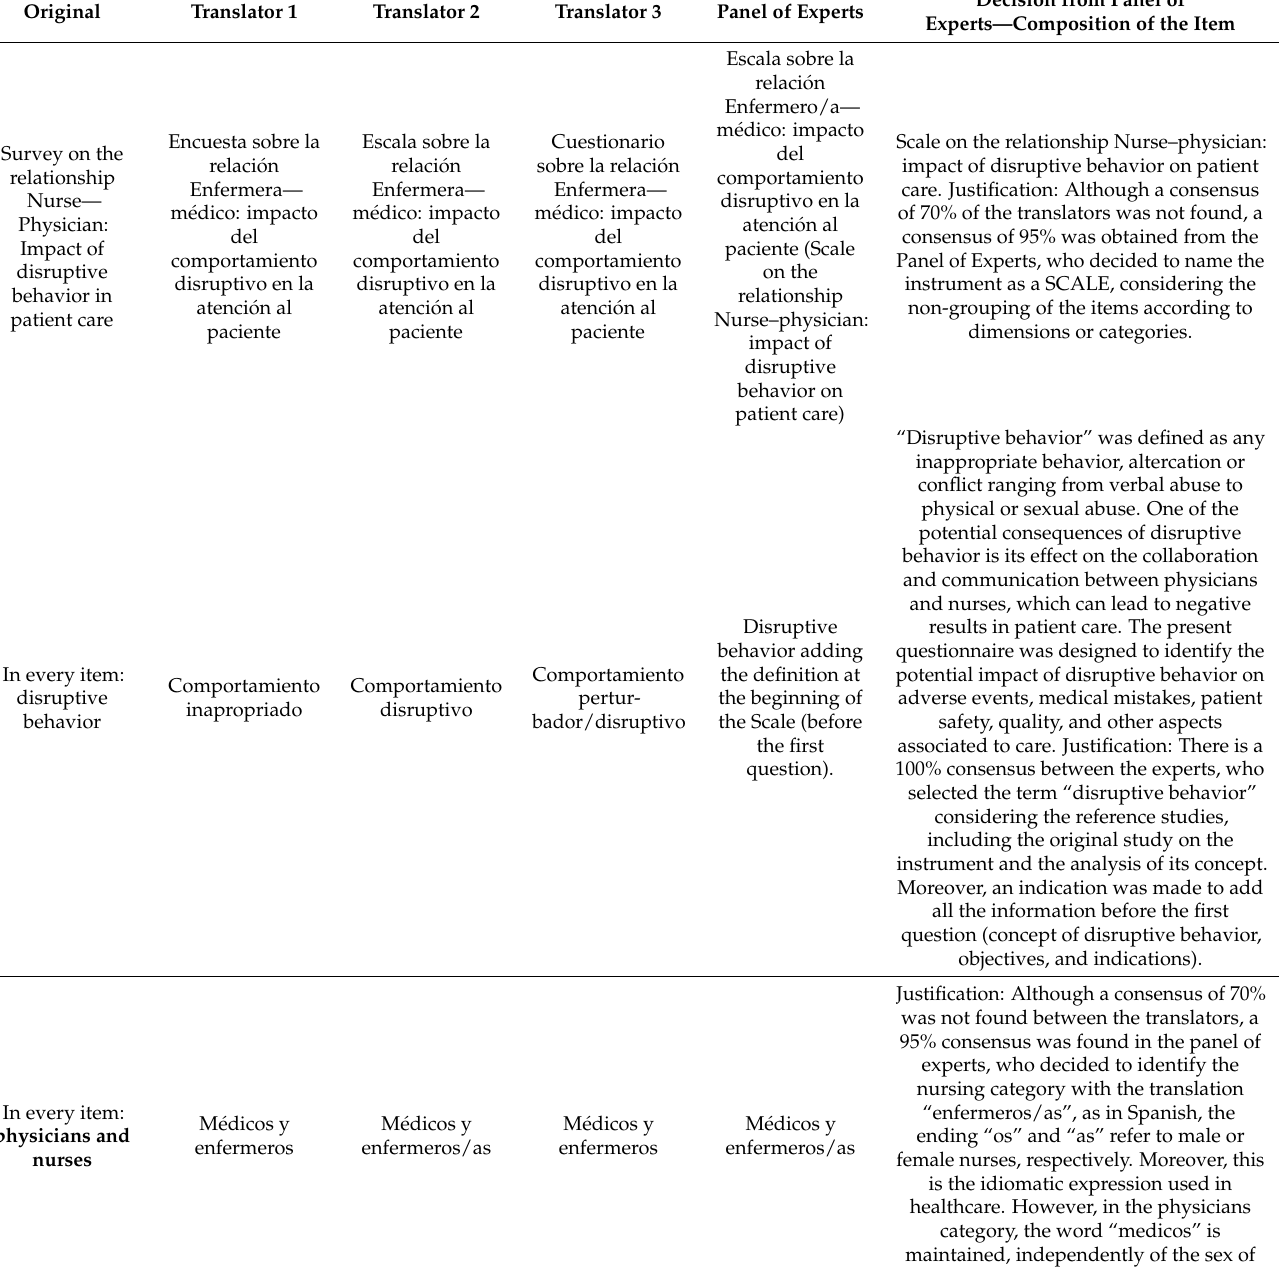
Table 2. Matrix of composition of the final items according to the panel of